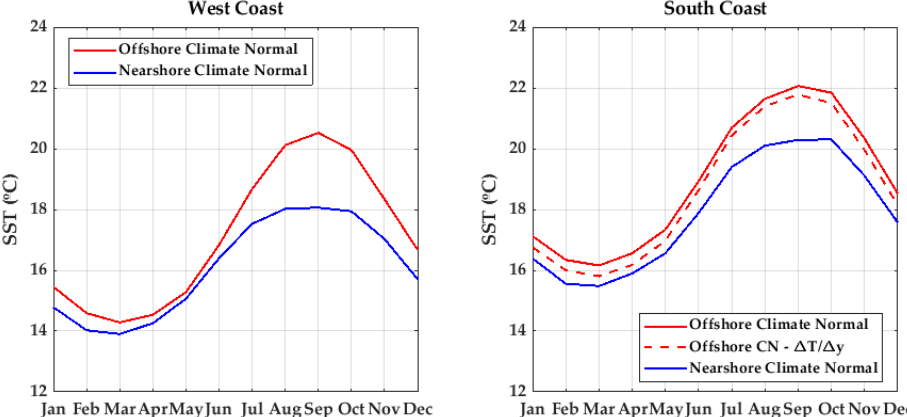
Figure 9. Climatological normals of nearshore and offshore spatial averages of the Portuguese west and south coasts, considering the entire period covered by the data.